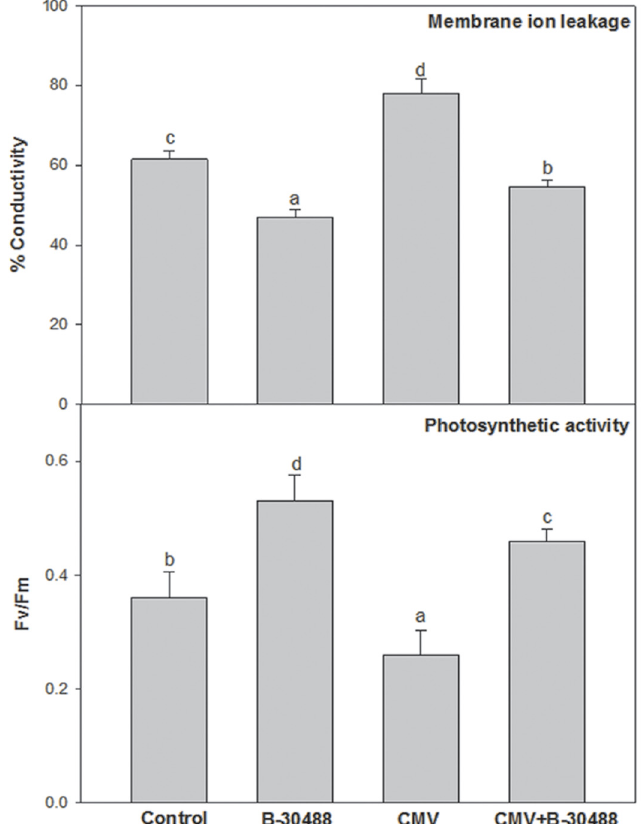
Fig 2. B-30488 inoculation improved the biophysical characters in tobacco plants. Graphs for biophysical (membrane ion leakage and photosynthetic activity) in systemic leaf of N . tabacum cv. White Burley plant collected from each treatment (Control, B-30488, CMV and B-30488+CMV) revealing the improved plant efficiency in bacterized plant. The data was calculated at 28